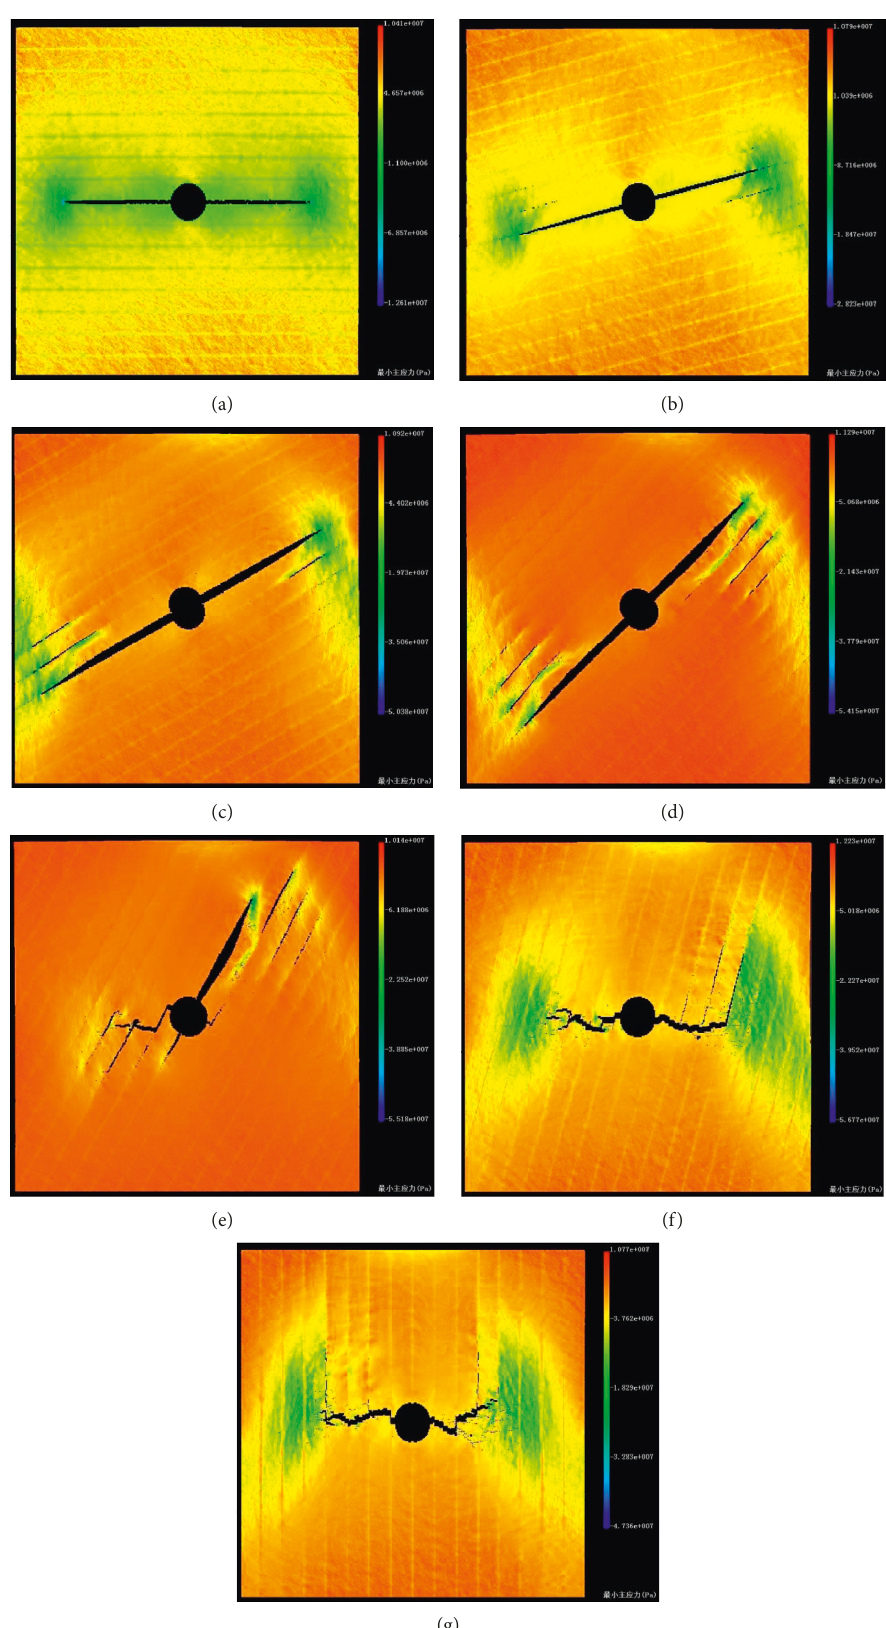
Figure 8: Minimum principal stress field of dip angle models. (a) α � 0 ° . (b) α � 15 ° . (c) α � 30 ° . (d) α � 45 ° . (e) α � 60 ° . (f) α � 75 ° . (g) α � 90 °